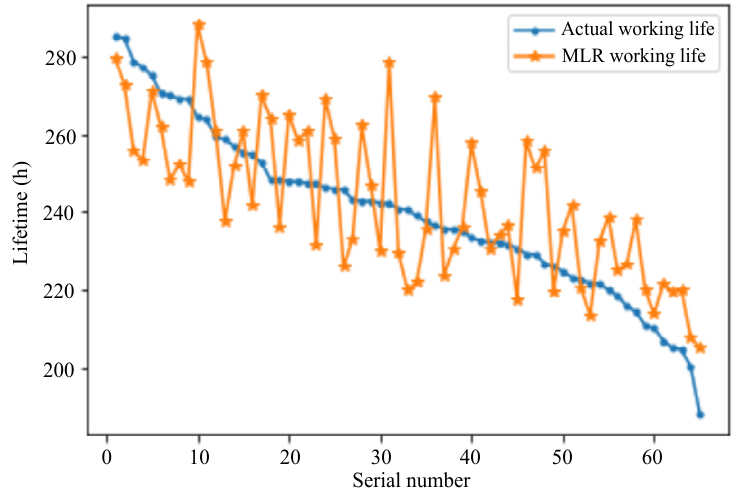
Figure 6. MLR model.